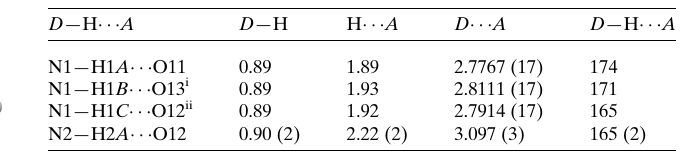
Table 1 Hydrogen-bond geometry (A˚ , (cid:5) ).